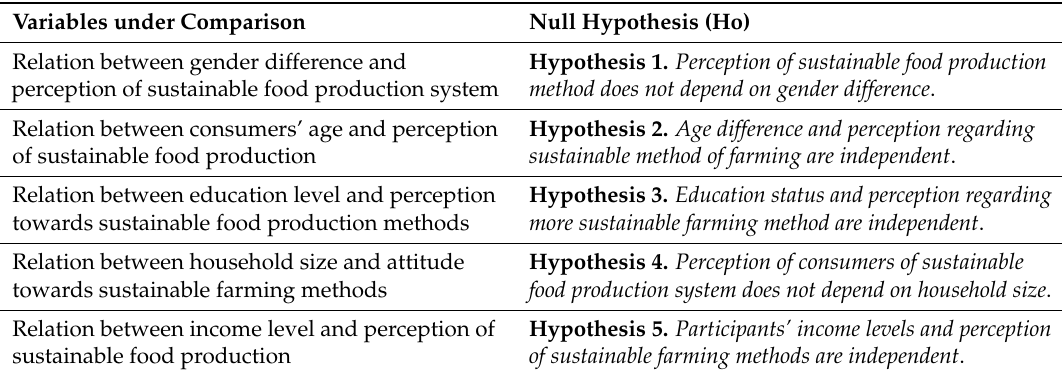
Table 1. List of null hypotheses and measurement